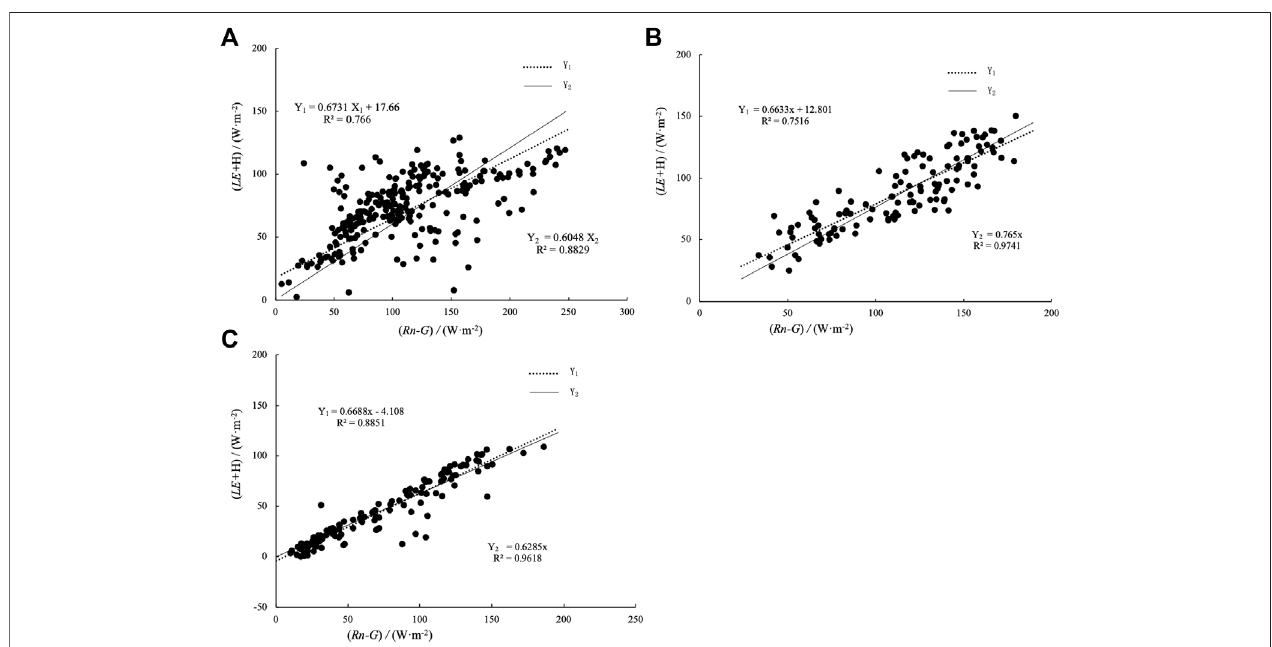
FIGURE 8 | Relationship between energy turbulent fl ux ( H + LE ) and effective energy ( Rn − G ) in different periods under the daily average data set. (A) 2019; (B) 2020; (C) 2021.